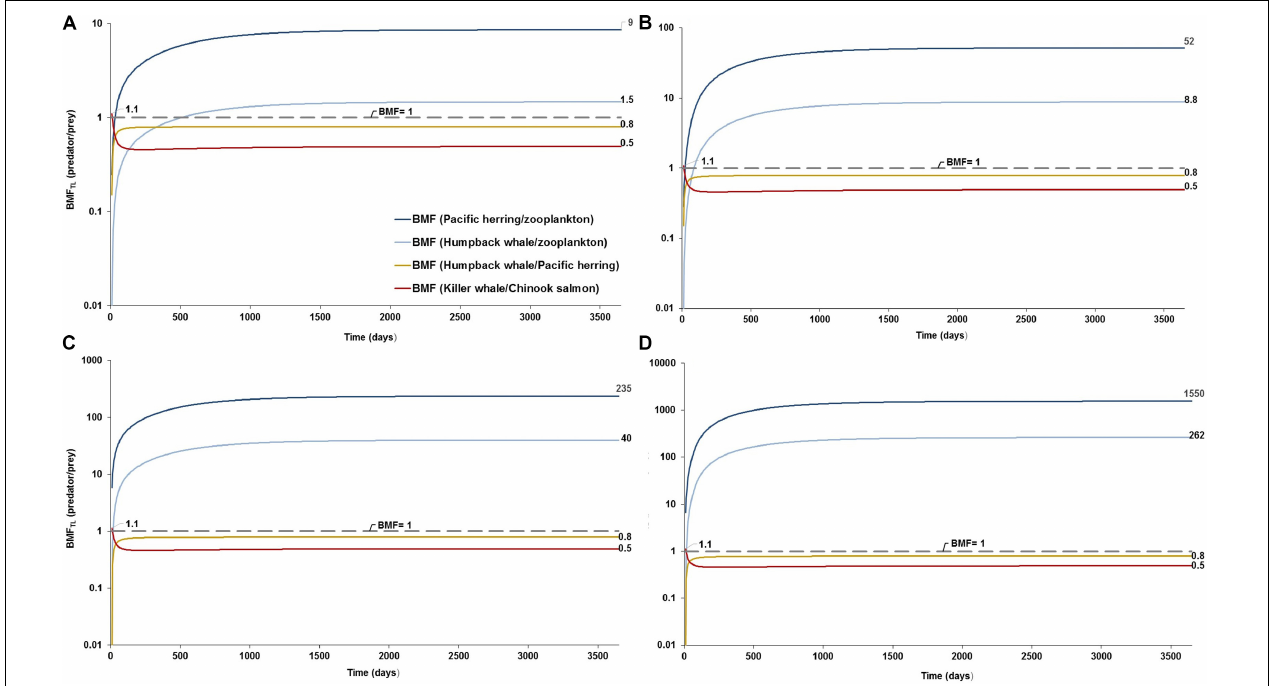
FIGURE 3 | Predator-prey biomagnification factor adjusted to the difference of trophic levels ( BMF TL ) and testing elimination rates based on the study by Cole et al. (2013): (A) BMF TL simulation with a low elimination rate of k E = 0.143/d at low concentrations in seawater and sediment (scenario 1: 0.003 g/L; and 0.266 g/kg dw, respectively) as a conservative scenario; (B) BMF TL simulation with a high elimination rate of k E = 1/d at low scenario 1 as a least conservative scenario; (C) BMF TL simulation with a k E = 0.143/d at high concentrations in water and sediment (scenario 3: 0.04 g/L; and 111 g/kg dw, respectively) as a conservative scenario; and (D) BMF TL simulation with a k E = 1/d at scenario 3, as a least conservative scenario (scenario 2). Dashed line represents equal partitioning or distribution of MP concentrations ( BMF TL = 1) between predator and